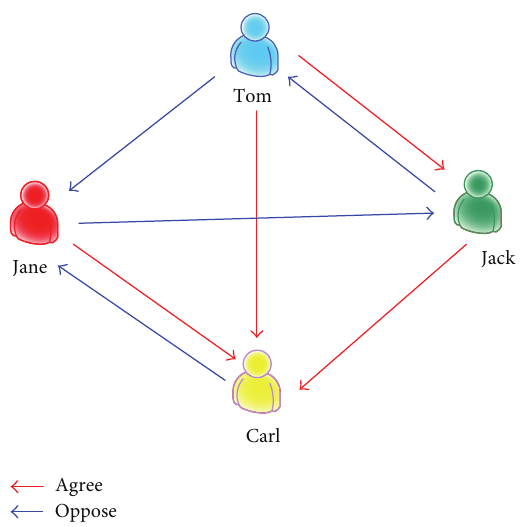
Figure 1: A toy example for social interactive